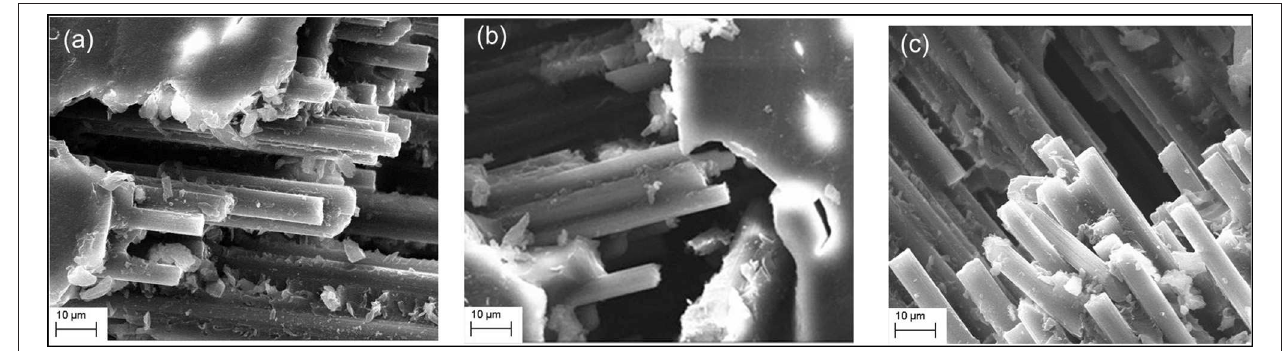
FIGURE 7 | SEM images of fracture surface (a) pure epoxy/carbon fiber composite, (b) 0.3wt.% GO/epoxy/carbon fiber composite, and (c) 0.5 wt.% GO/epoxy/carbon fiber